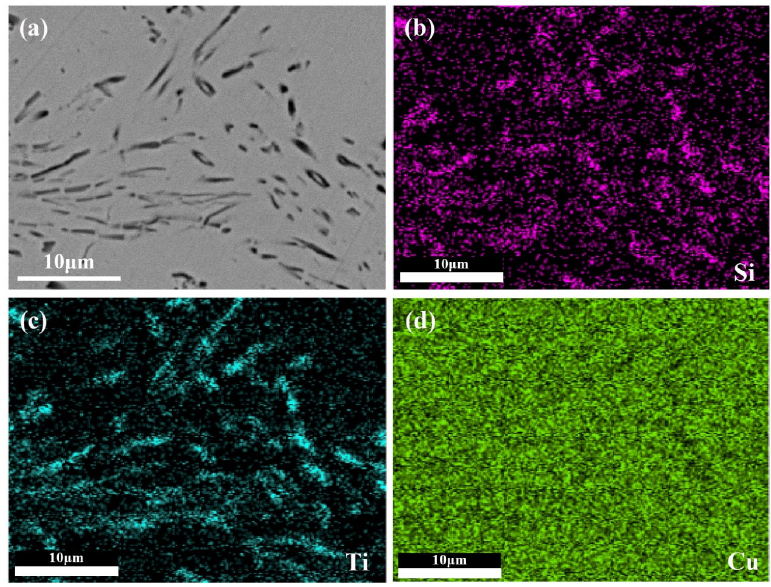
Figure 3. EDS mapping analysis of the Ti 5 Si 3 in prepared as ‐ cast composites. ( a ) Microstructures of the Ti 5 Si 3 in prepared as ‐ cast composites; ( b – d ) mapping micrographs of Si, Ti and Cu elements.